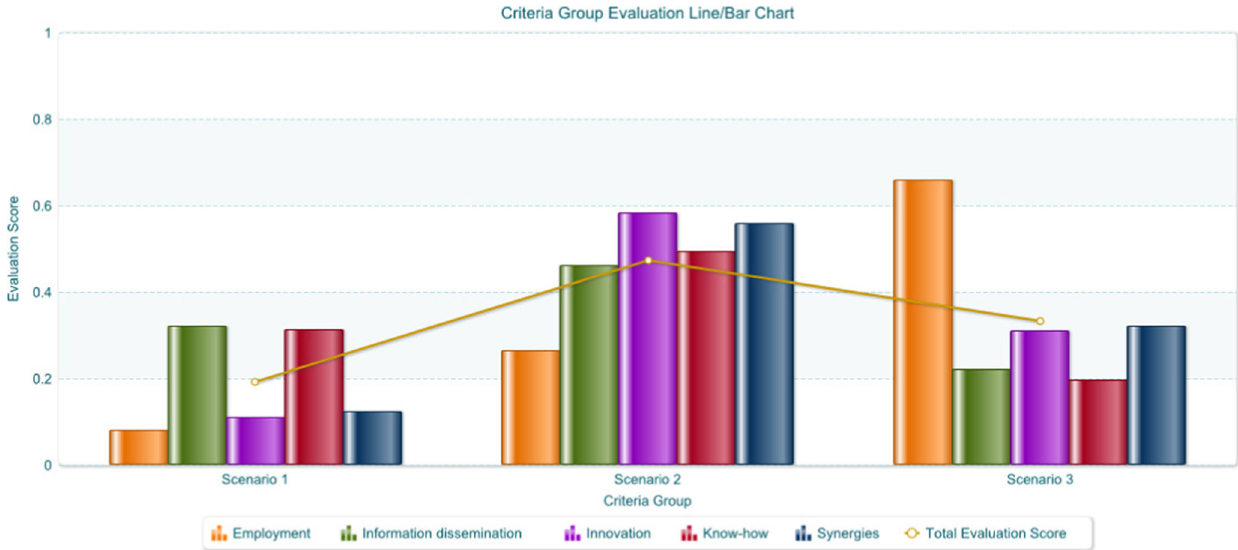
Fig. 11 Criteria Group F Evaluation Line/Bar Chart (MAMCA Software, own